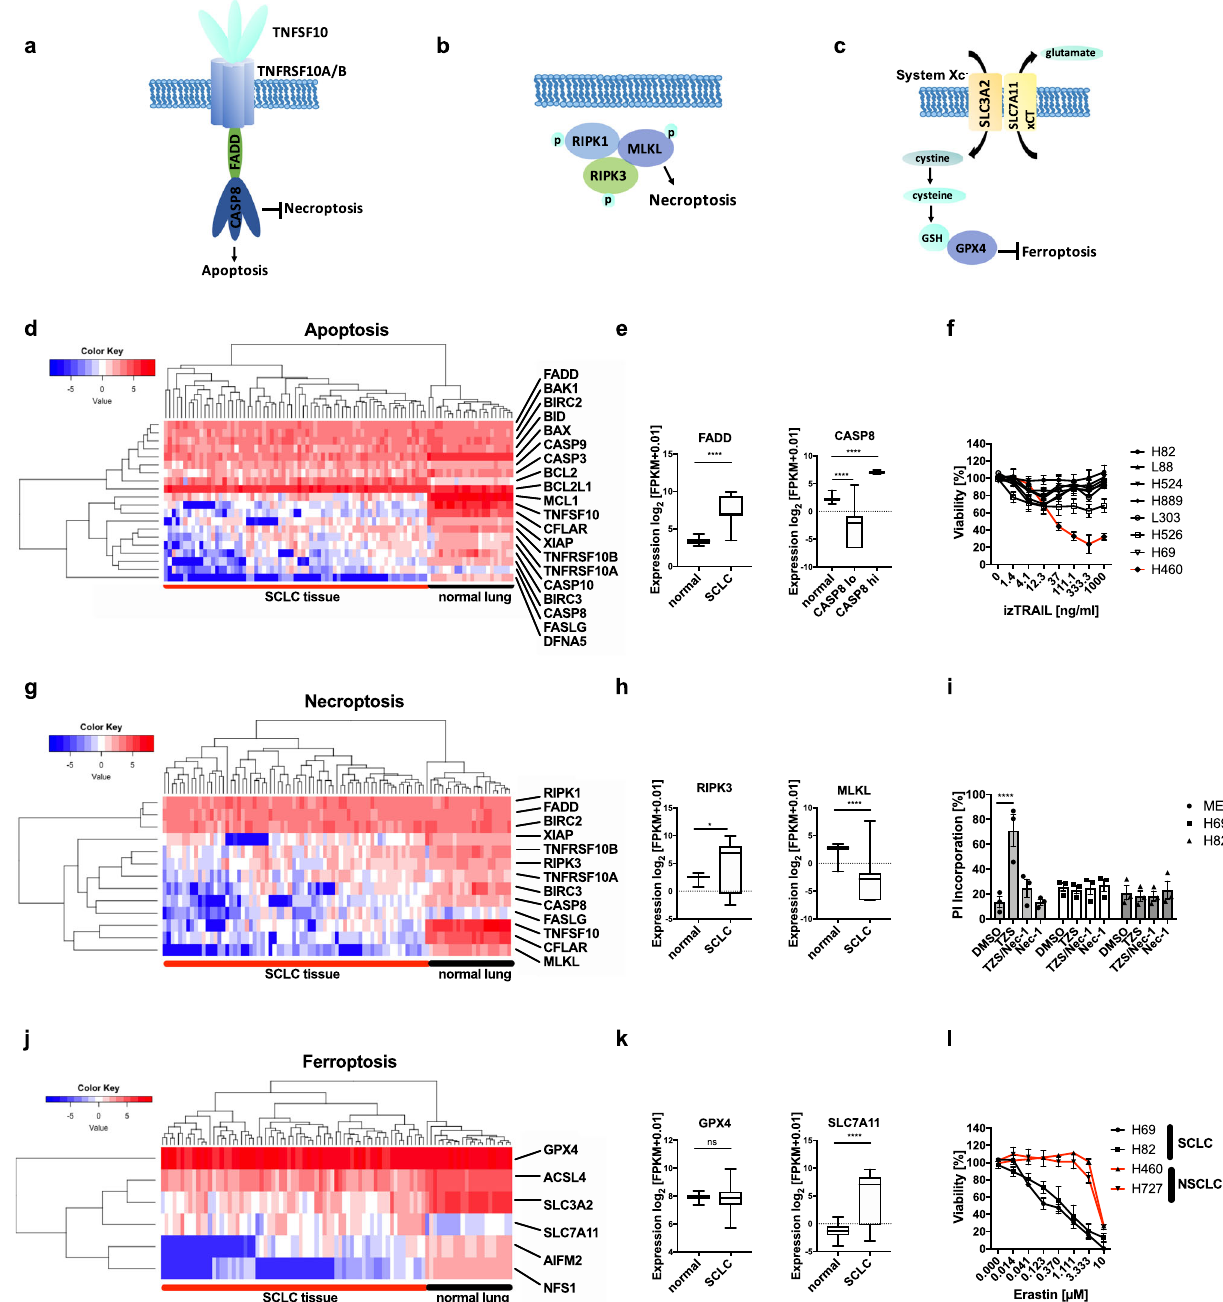
Fig. 1 Regulated cell death pathways are counter-selected in treatment-naïve SCLC. a Schematic view of genes involved in extrinsic apoptosis, b necroptosis and c ferroptosis. d , e , g , h , j , k RNA-seq expression data in FPKM (fragments per kilobase of exon model per million reads mapped) from normal lung 85 ( n = 22) and mostly chemo-naïve SCLC patient samples 7 ( n = 67) were log2 transformed ( + 0.01) and plotted for relative expression of genes involved in extrinsic apoptosis ( d , e ) necroptosis ( g , h ) and ferroptosis ( j , k ) boxplot center line, mean; box limits, upper and lower quartile; whiskers min. to max. Heatmap color code indicates expression levels between each sample and the average of each gene, dendrogram shows the distance between sample populations. f The indicated seven human SCLC cell lines ( n = 7) and NSCLC cell line (H460) were treated with human izTRAIL for 24 h, cell viability was determined by Cell Titer Blue, n (H82) = 6, n (L88) = 4, n (H524) = 4, n (H889) = 4, n (L303) = 3, n (H526) = 3, n (H69) = 5, n (H460) = 3. i Cells were treated with TNF (T) [10 ng/ml]/zVAD (Z) [20 µ M]/Smac mimetic (S) Birinapant [1 µ M] + / − Nec-1 [10 µ M] for 24 h, cell death was quanti fi ed by propidium iodide (PI) uptake and fl ow cytometry. l Cells were treated with erastin at indicated concentrations for 24 h, cell viability was determined by Cell Titer Blue. Data are means± SEM of three independent experiments wherever not indicated otherwise. Two-way ANOVA + Tukey ’ s multiple comparison test ( i ) and two-tailed unpaired t tests for all others, **** p < 0.0001, * p < 0.05, ns p > 0.05. Source data are provided as Source data fi le.